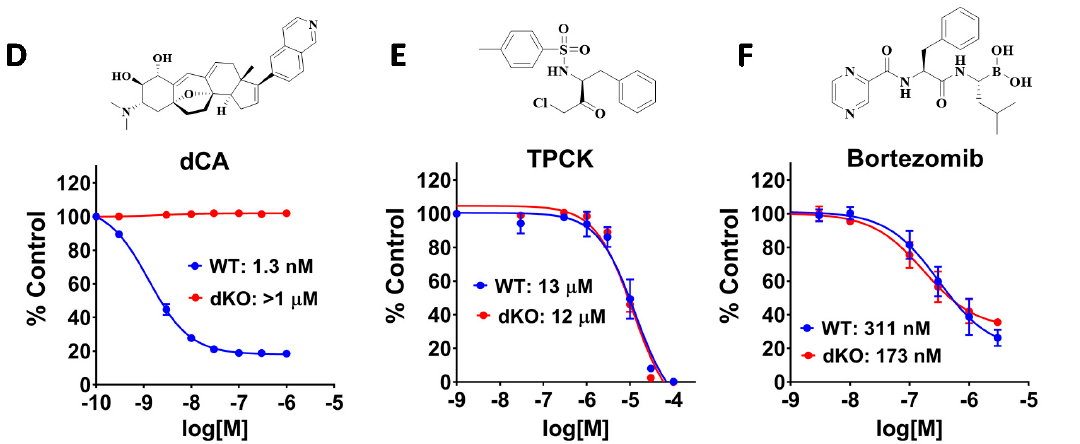
Figure 2. ( A ) Schematic of lentiviral construct pHAGE-NFkB-TA-LUC-UBC-dTomato. ( B ) E ff ects of treatment with 10 ng / mL TNF α , 1 µ M senexin B or their combination on luciferase expression in the indicated pooled populations or clones of wild-type (WT) and double knockout (dKO) cells. Data are presented as mean ± SEM ( n = 3). Asterisks: p < 0.01 for the di ff erence between TNF α and TNF α + senexin B readouts. ( C ) E ff ects of di ff erent concentrations of senexin B on luciferase expression in the indicated WT and dKO 293 clones treated with 10 ng / mL TNF α for 3 h. % control (Y axis) was calculated relative to cells without the inhibitor. ( D – F ) E ff ects of di ff erent concentrations of dCA, TPCK